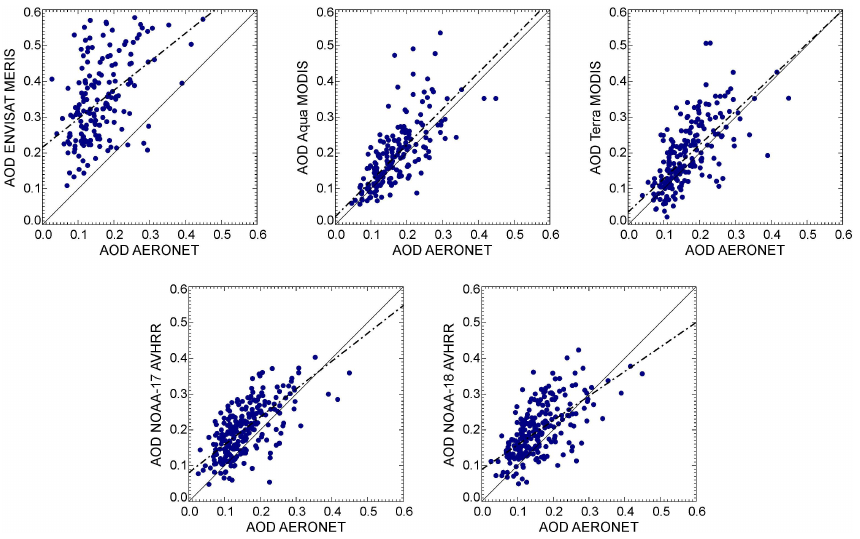
Fig. 7. Scatter plots of monthly average τ a between AERONET and the various satellites. The 1:1 intersection (solid) and the linear regression line (dash-dotted) are shown as well. Detailed statistical results are shown in Table 4.